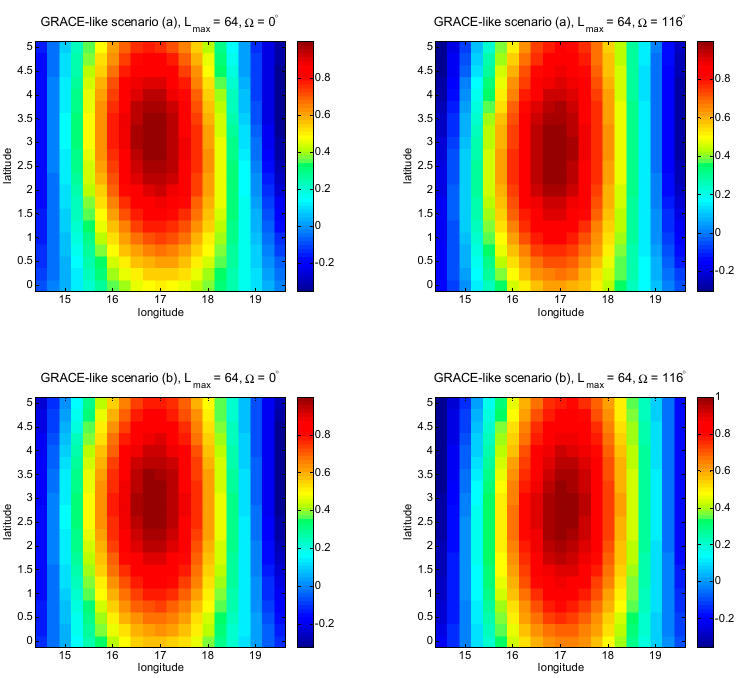
Figure 22. Spatial covariance of a selected point in West Africa (from Figures 19 and 20) for 6-day solution of the inline formation up to L max = 64, for top : scenario (a), and bottom : scenario (b). Left is Ω = 0° and right is Ω = 116°.